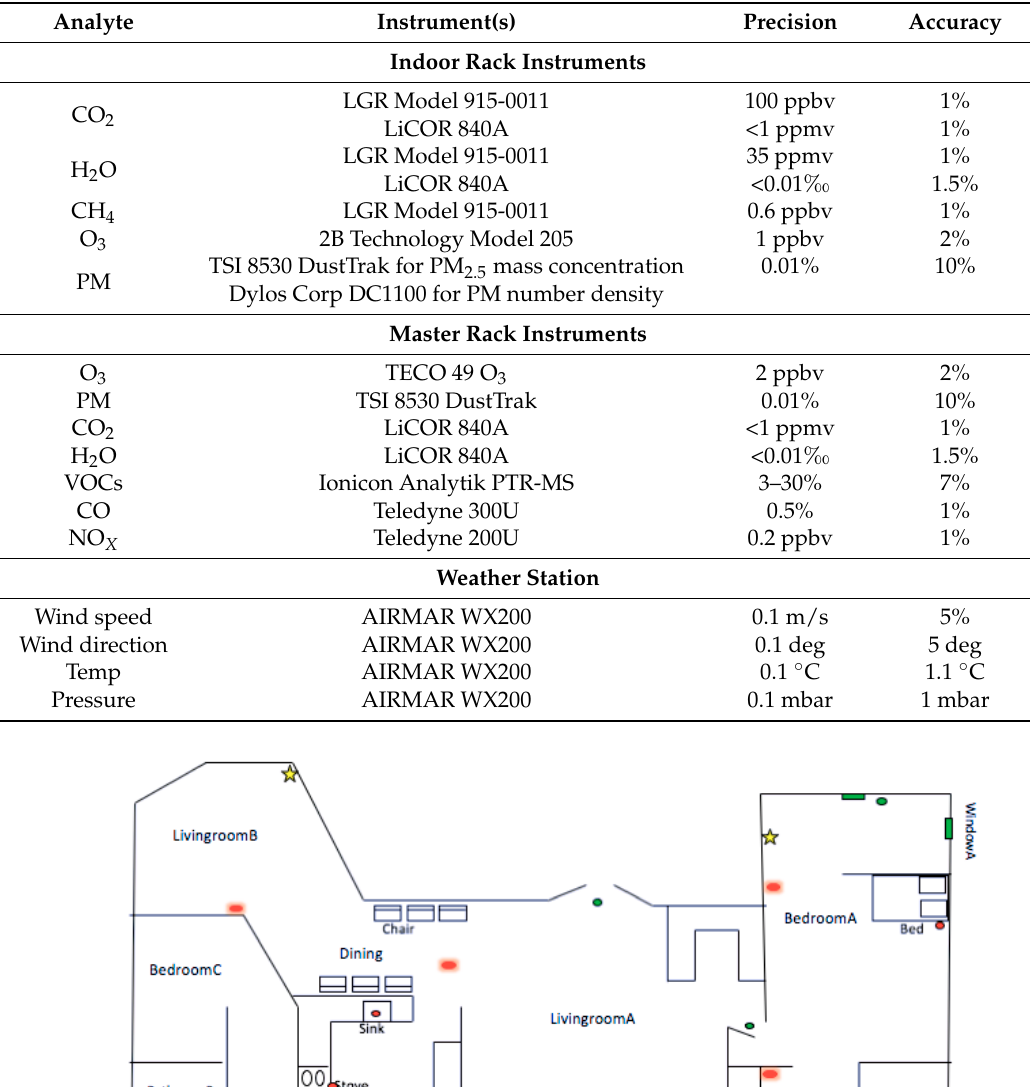
Table 1. Instruments for indoor air quality (IAQ) chemical data collection.